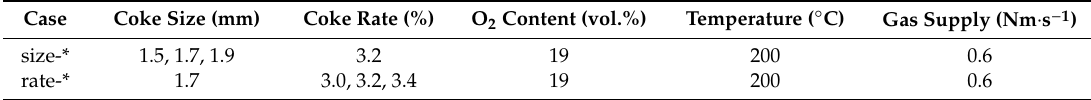
Table 5. Simulation